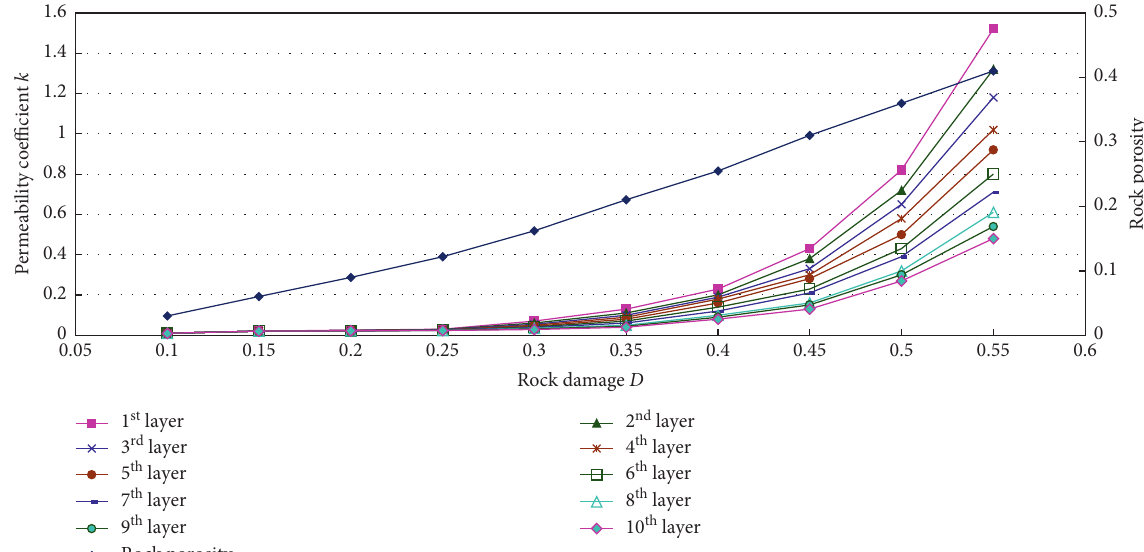
120 + A 2 fault along the depth.